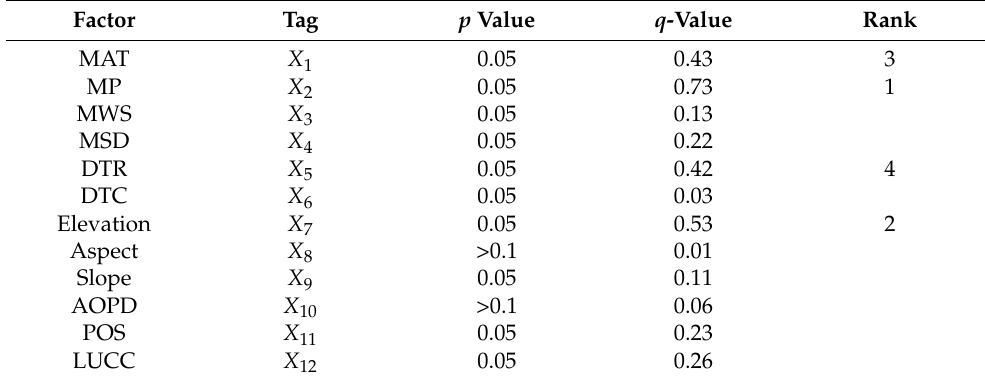
Table 4. q statistics and ecological